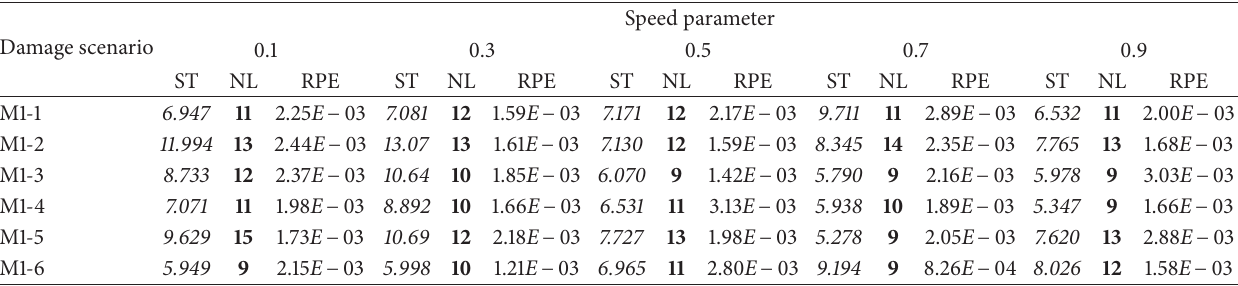
Table 4: Solution time, loops, and RPE of DDM method for model 1.